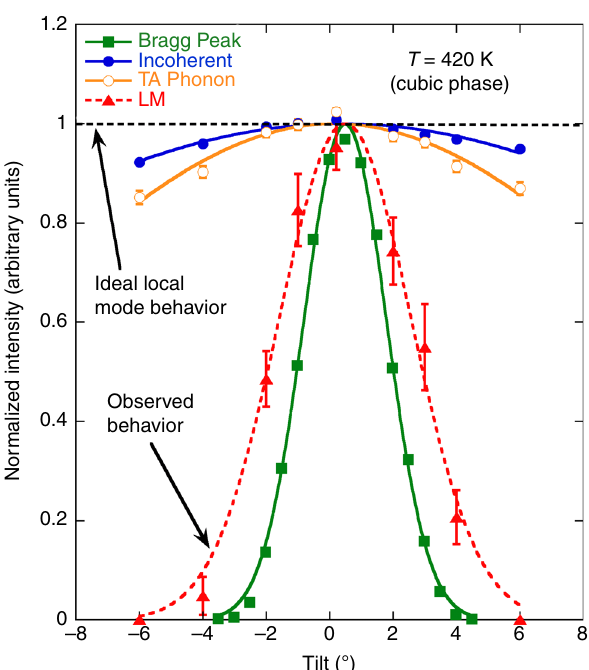
Fig. 1 Tilt dependence of neutron scattering in cubic PMN-0.29PT. The scattering cross sections are obtained at Q = (2, − 0.35,0). LM refers to the feature identi fi ed as a local mode by Manley et al. 1 Lines are fi ts to Gaussian lineshapes. Errors bars, taken from least-squares fi ts, denote ± 1 standard